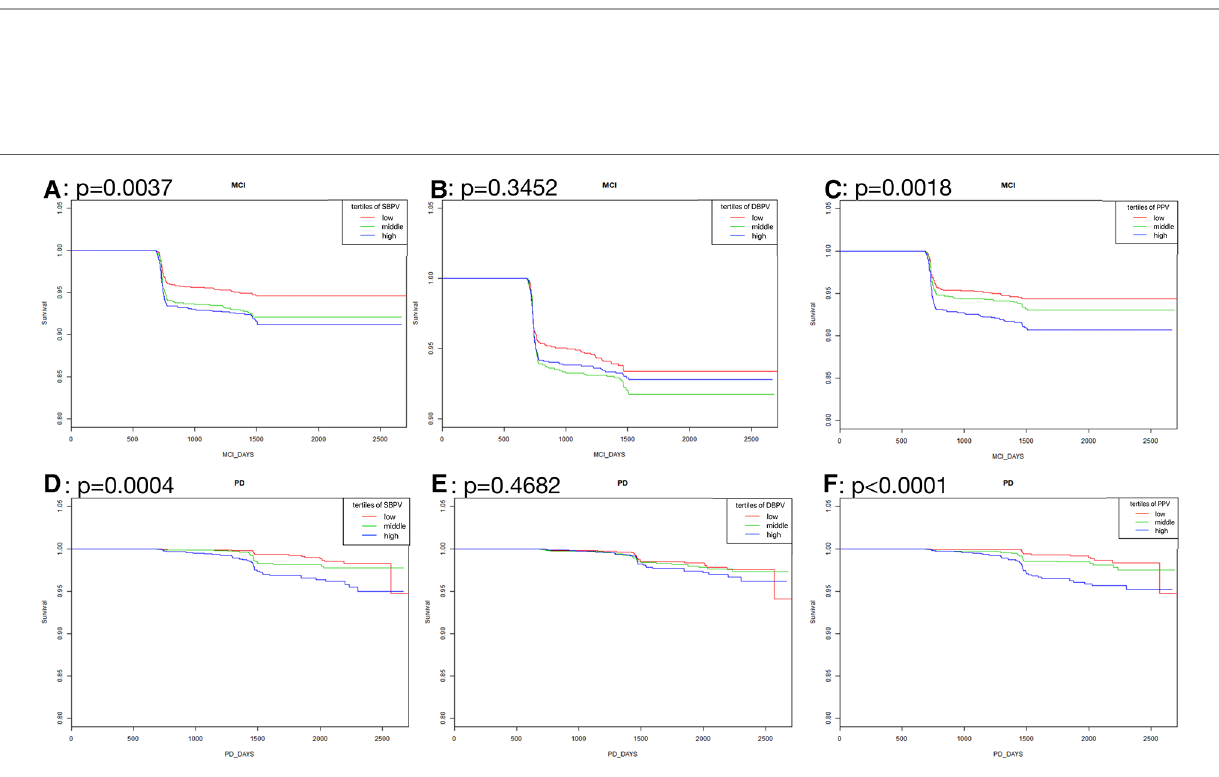
FIGURE 2 Kaplan-Meier curves analysis among tertiles of BPV in standard blood pressure treatment. ( A – C ) Showed the rates free of mild cognitive impairment in follow-up after strati fi cation by SBPV, DBPV and PPV in standard blood pressure treatment; ( D – F ) showed the rates free of probable dementia in follow- up after strati fi cation by SBPV, DBPV and PPV in standard blood pressure treatment.